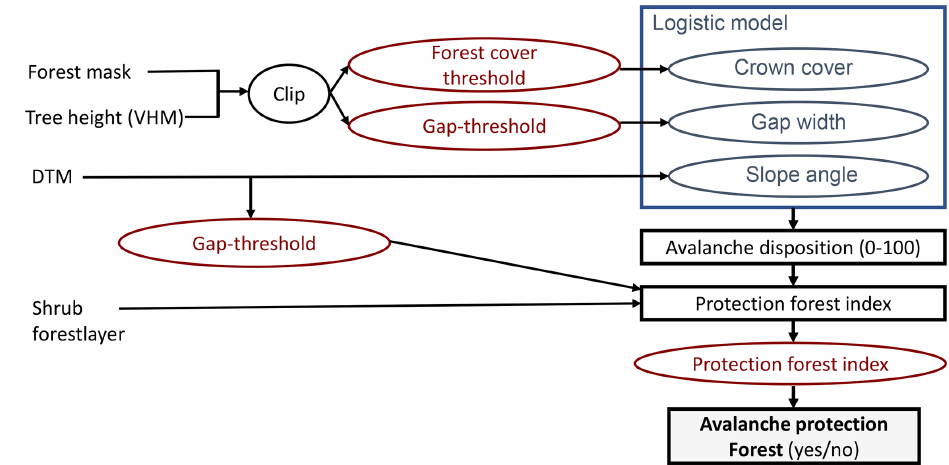
Figure 2. Schematic structure of the model for calculating the spatial extent of potential avalanche protection forest, simplified according to (Bebi et al., 2021).